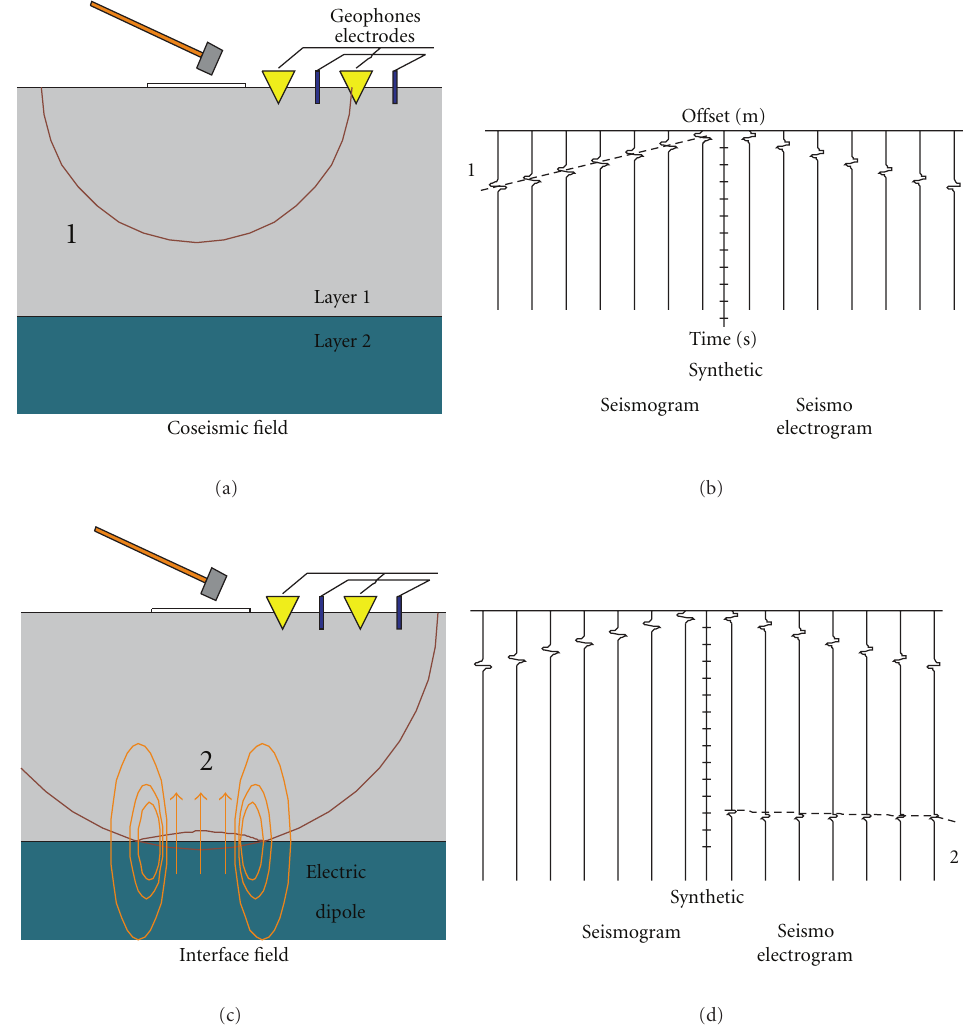
Figure 2: Schematic of a “standard” geometry for a seismoelectric survey (modified from Haines [5], Kroeger [6, 15]). One fluid-saturated porous layer (layer 1) overlies a porous half-space (layer 2), with contrasting medium parameters (panels (a) and (c)). The seismic source gen- erates longitudinal wave (labelled 1) that is recorded by surface geophones (left part of panel (b)). This wave also creates a coseismic electric field that is registered by the surface electrodes (right part of panel (b)). When the longitudinal wave arrives at the interface between the porous layers, the interface field is generated (labelled 2), that is also recorded by the surface electrodes (right part of panel